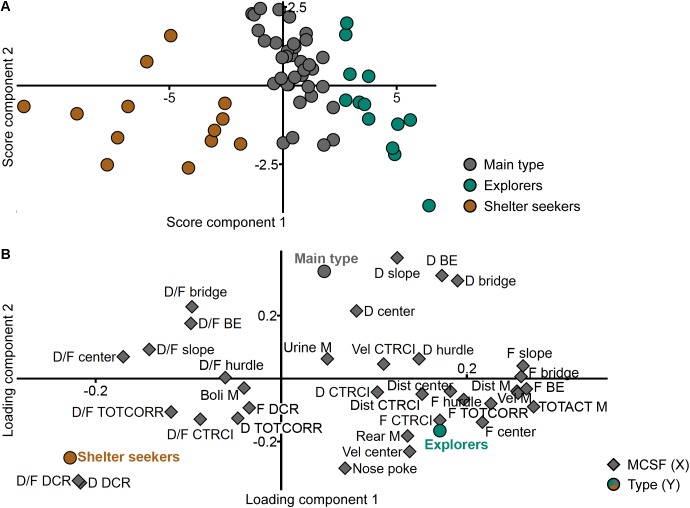
Validation of the behavioral types. Scatter plots of (A) individual scores and (B) variable loadings from the PLS-DA (n = 62, one significant component: R2X = 0.359, R2Y = 0.343, Q2 = 0.277; a second, non-significant component was added to obtain a two-dimensional model for visualization: R2X = 0.080, R2Y = 0.143, Q2 = –0.046) of the MCSF parameters (X) by behavioral type (Y). BE, bridge entrance; CTRCI, central circle; D, duration; DCR, dark corner room; Dist, distance; F, frequency; M, MCSF; TOTACT, total activity; TOTCORR, total corridor; Vel, velocity.